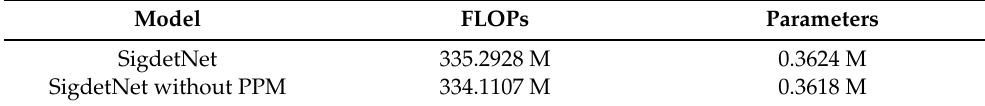
Table 1. The comparison of